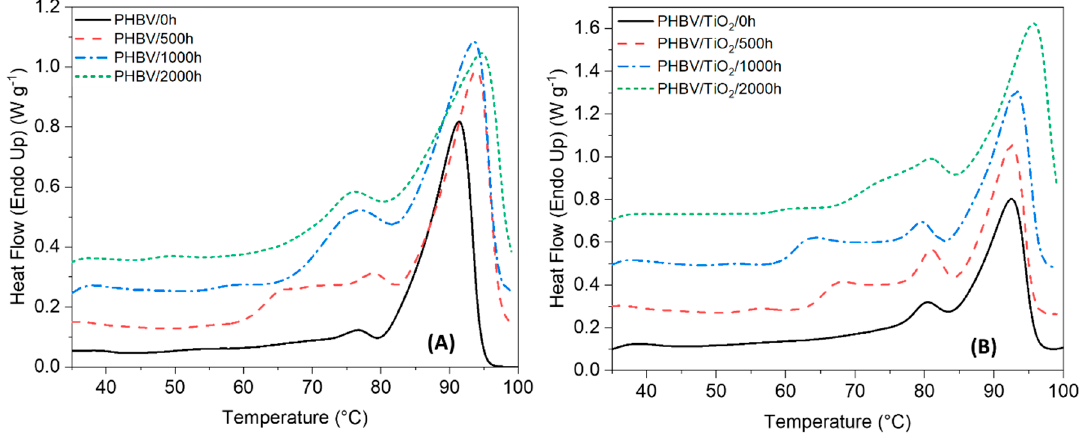
Figure 8. Differential scanning calorimetry (DSC) first heating curves of ( A ) the PHBV and ( B ) the PHBV/TiO 2 nanocomposites, before and after the different periods of accelerated weathering degradation.